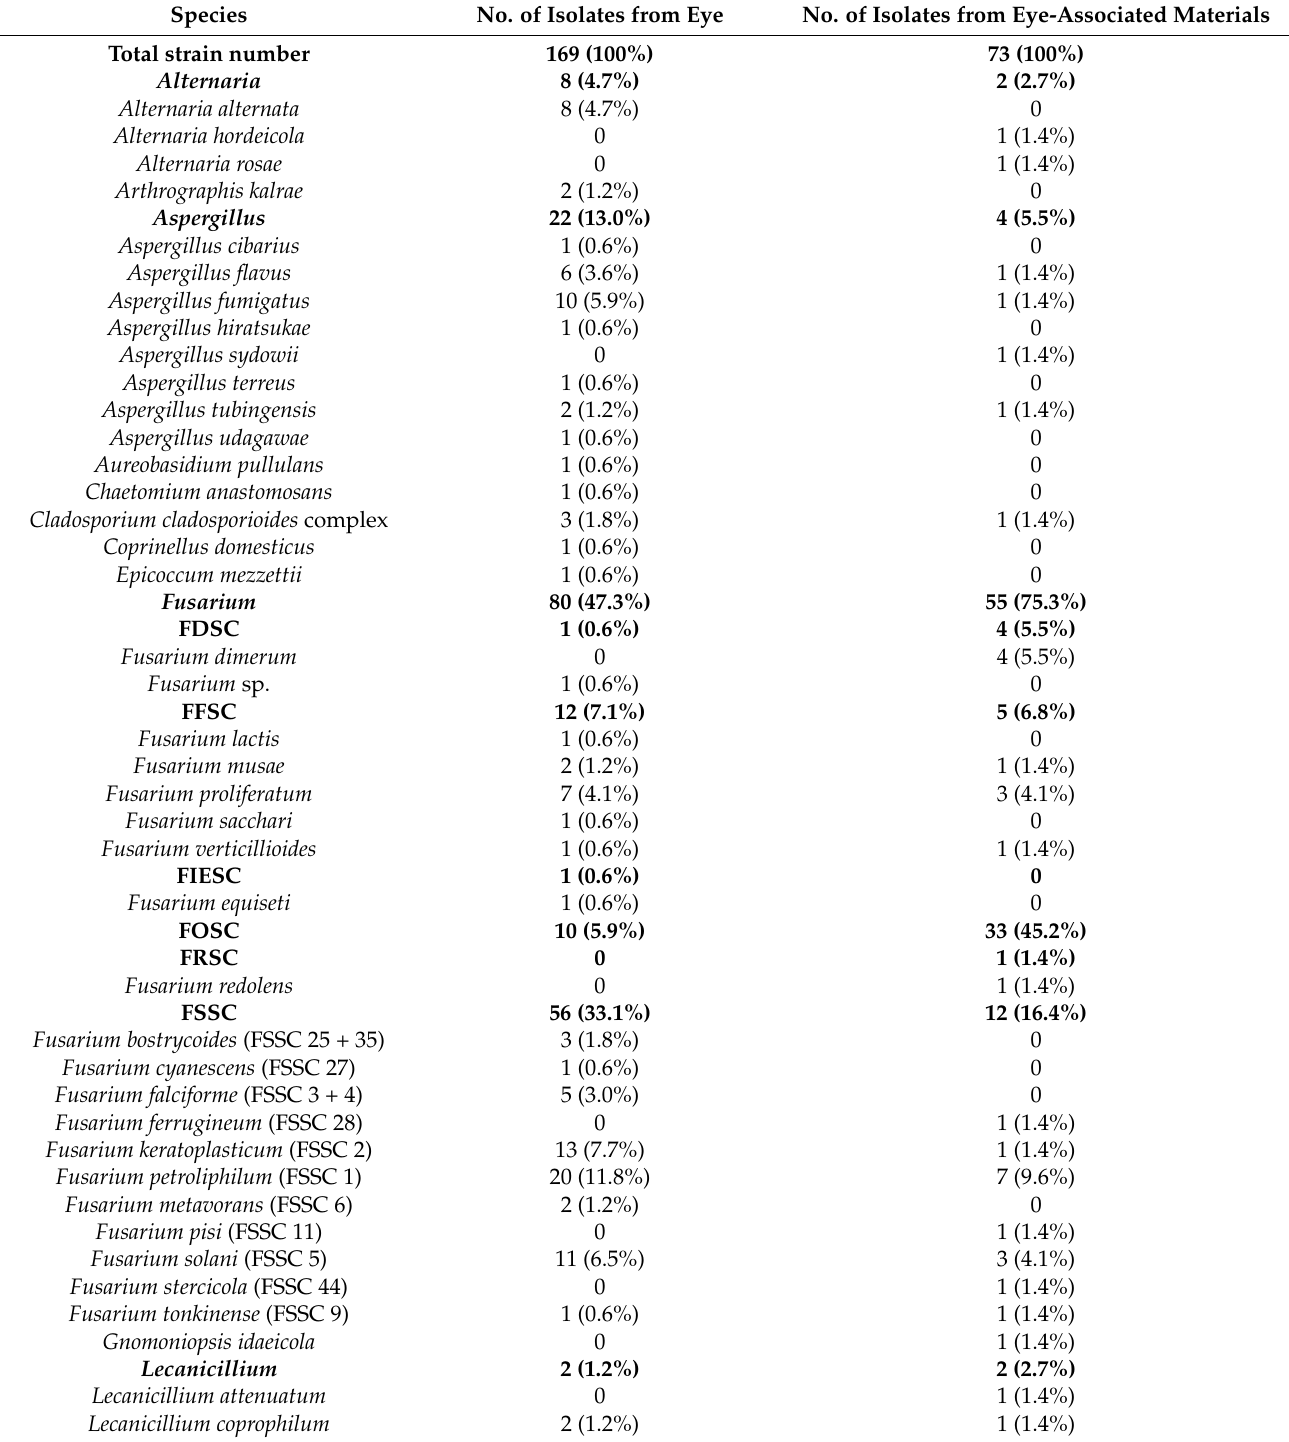
Table 1. Spectrum of fungi isolated from infected eyes and associated materials (corneal and conjunctival swabs, aspirates of the anterior chamber and the vitreous body). For the FSSC, the numbering of the phylogenetic species is given in brackets. Species No. of Isolates from Eye No. of Isolates from Eye-Associated Materials Total strain number 169 (100%)